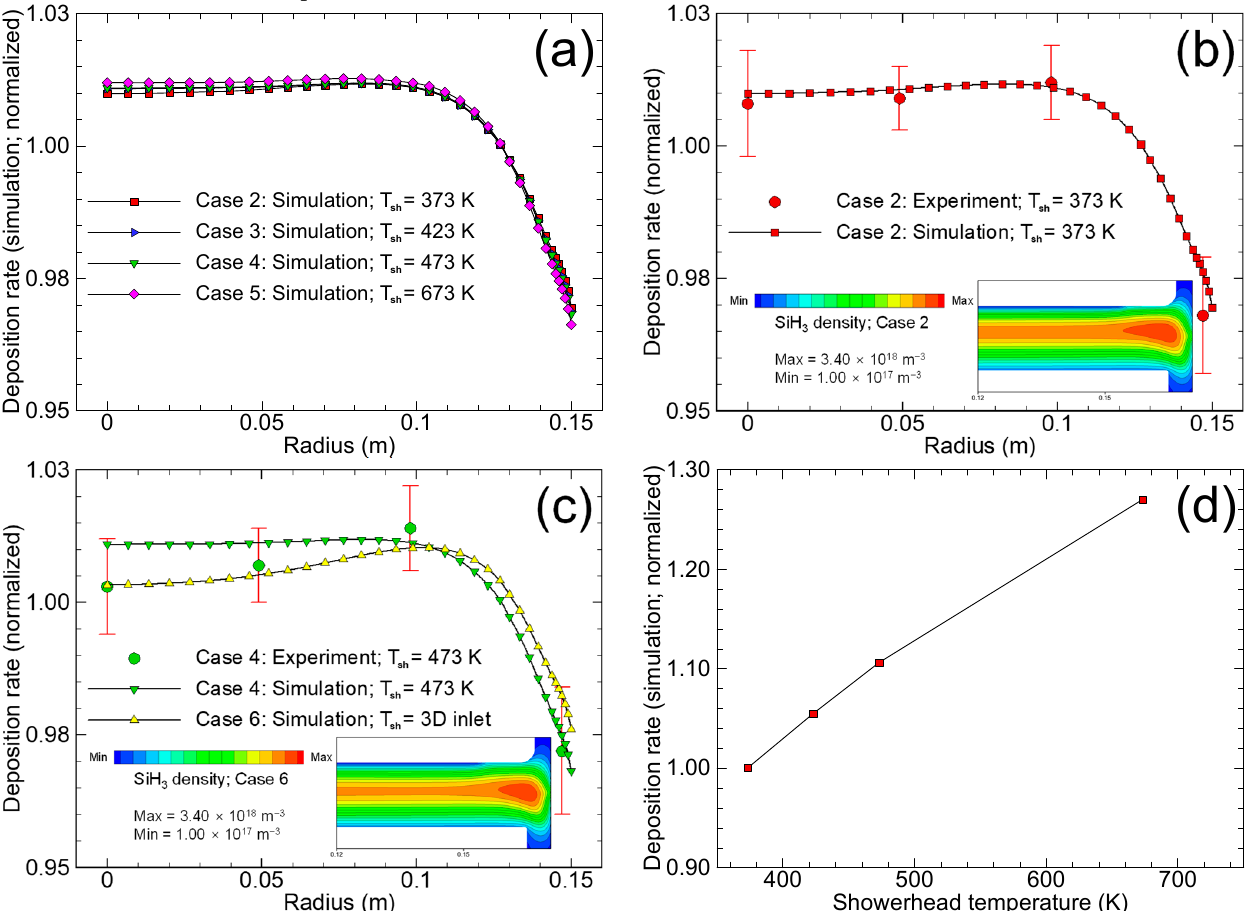
Figure 9. Deposition rates are largely affected by the showerhead temperature. ( a ) The deposition rate profiles are plotted for Cases 2 ( T sh = 373 K), 3 ( T sh = 423 K), 4 ( T sh = 473 K), and 5 ( T sh = 673 K). ( b ) For Case 2, the experimental data are superimposed. ( c ) For Cases 4 and 6, the experimental data are superimposed. ( d ) For Cases 2, 3, 4, and 5, the averaged values of the normalized deposition rates are plotted against the showerhead temperature. The experimental data are denoted with larger circle symbols.